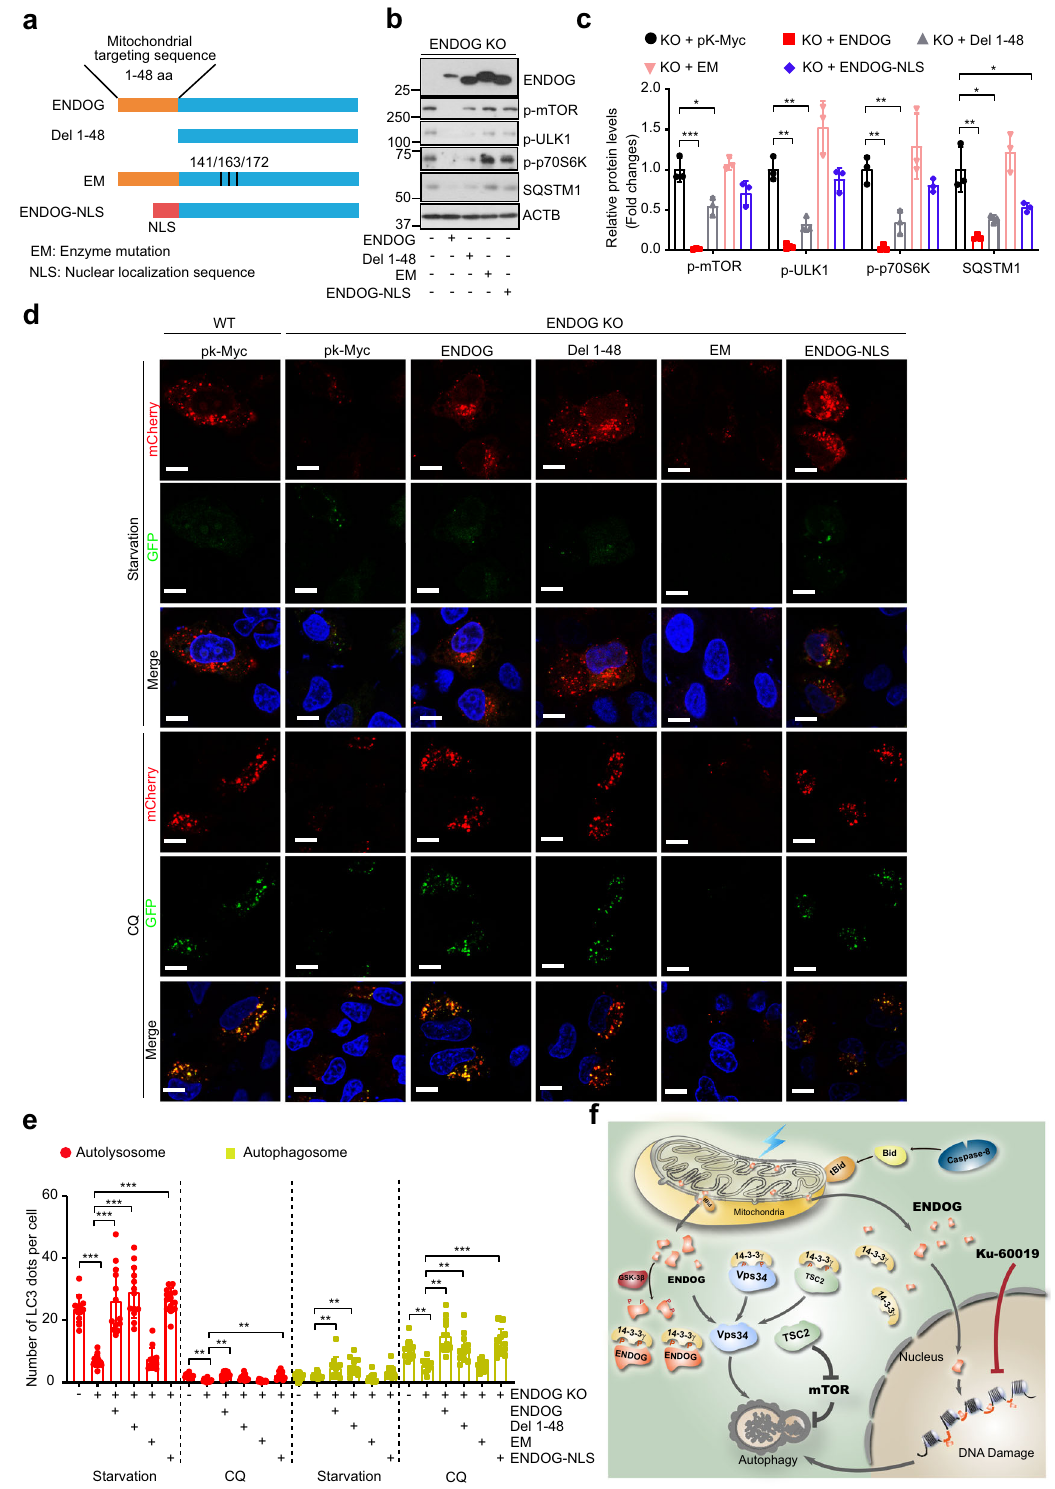
were identi fi ed by PCR followed by sequence analysis. F0 mice were mated with the wild-type mice (C57BL/6) to generate the F1 mice (Endog + / − ); F1 male mice were crossed with F1 female mice to generate the F2 mice (Endog + / − and Endog − / − ) for experiments. Three-month-old male mice (Endog + / − and Endog − / − ) were used in this study. Mice were maintained on a 12 light/12 dark cycle (light on 7 AM to 7 PM), at a room temperature of 22°C ± 2°C, humidity of 50% ± 5%, with free access to food and water. The animals were handled according to the Guidelines of the China Animal Welfare Legislation and as approved by the Laboratory Animal Ethics Committee of JINAN University. NATURE COMMUNICATIONS| (2021) 12:476